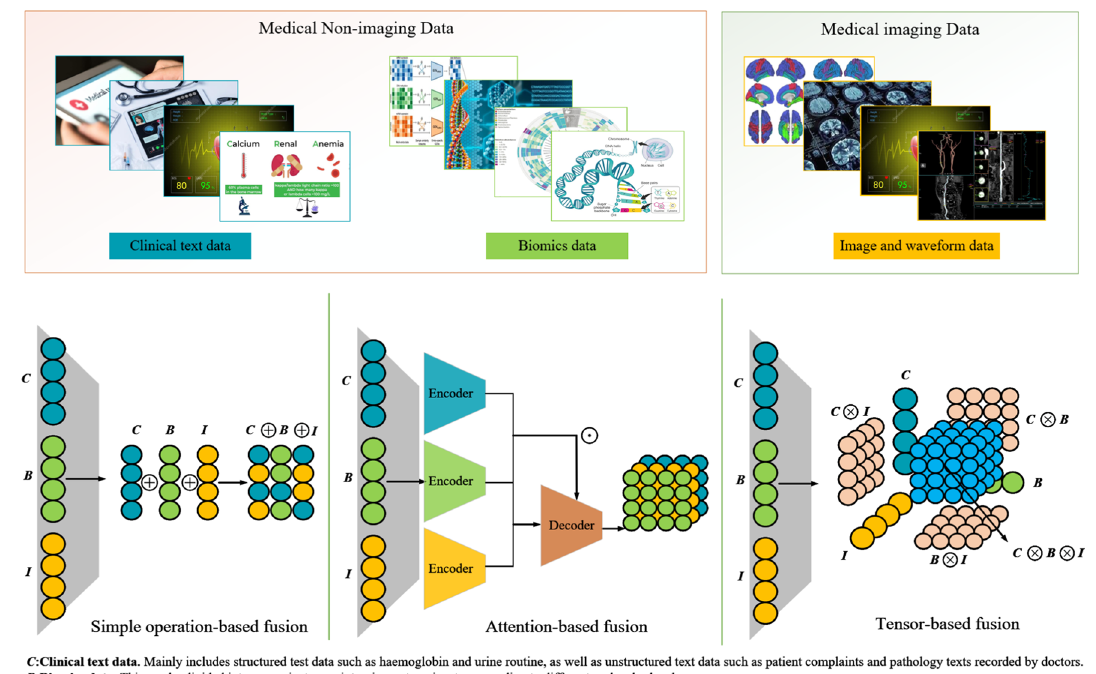
Fig. 2 Schematic diagram of the structure of the three multi-modal fusion